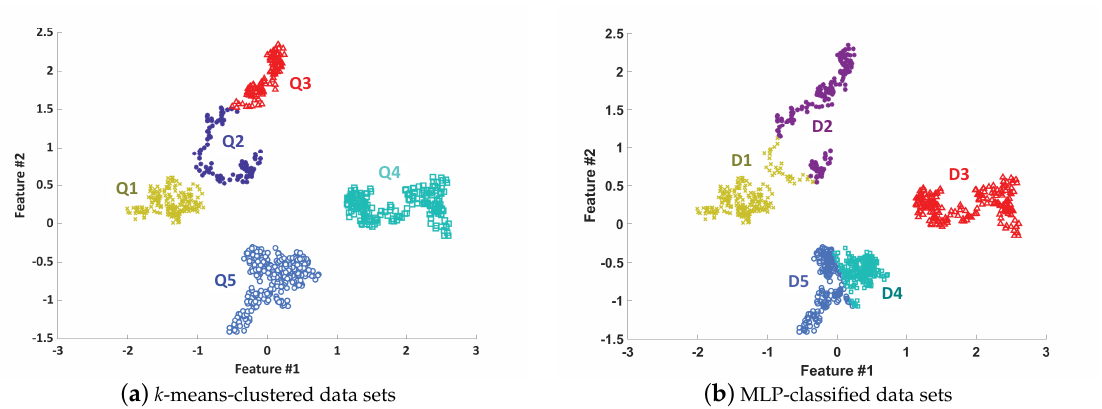
Figure 1. Distribution consistency measures between k -means-clustered and MLP-classified data sets ( σ 2 =